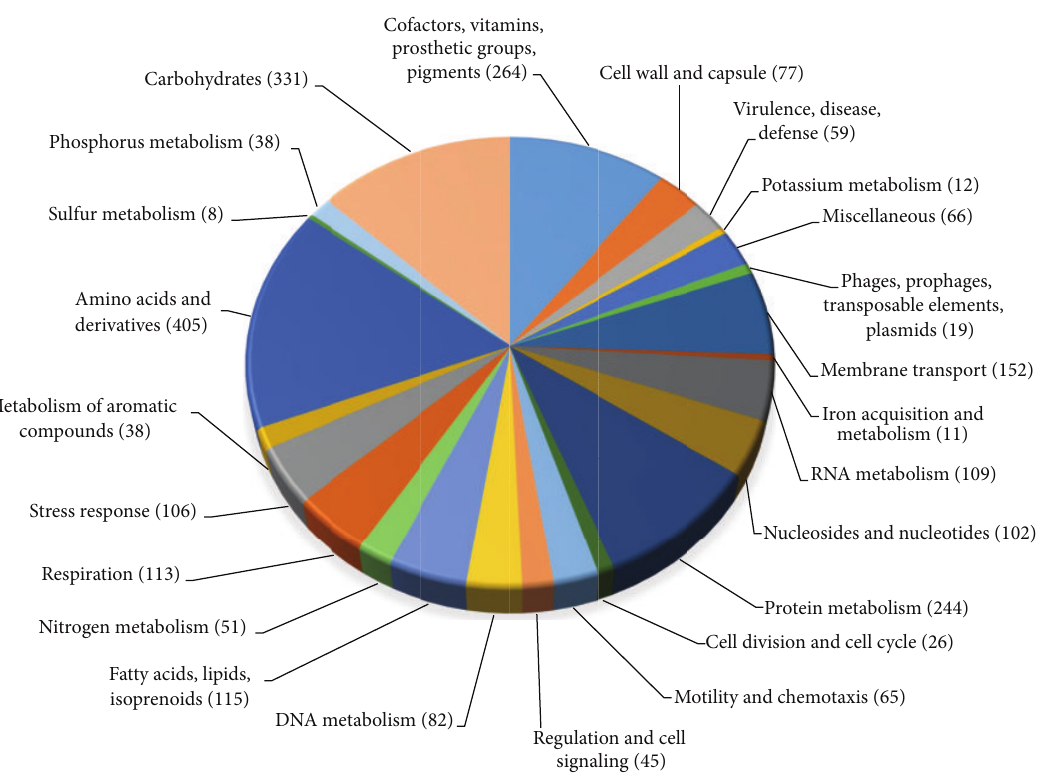
Figure 3: Distribution of subsystem category for B . melitensis IND1. Bm IND1 genome sequence was annotated using Rapid Annotation System Technology server. Features of each subsystem and their coverage are summarized in the pie